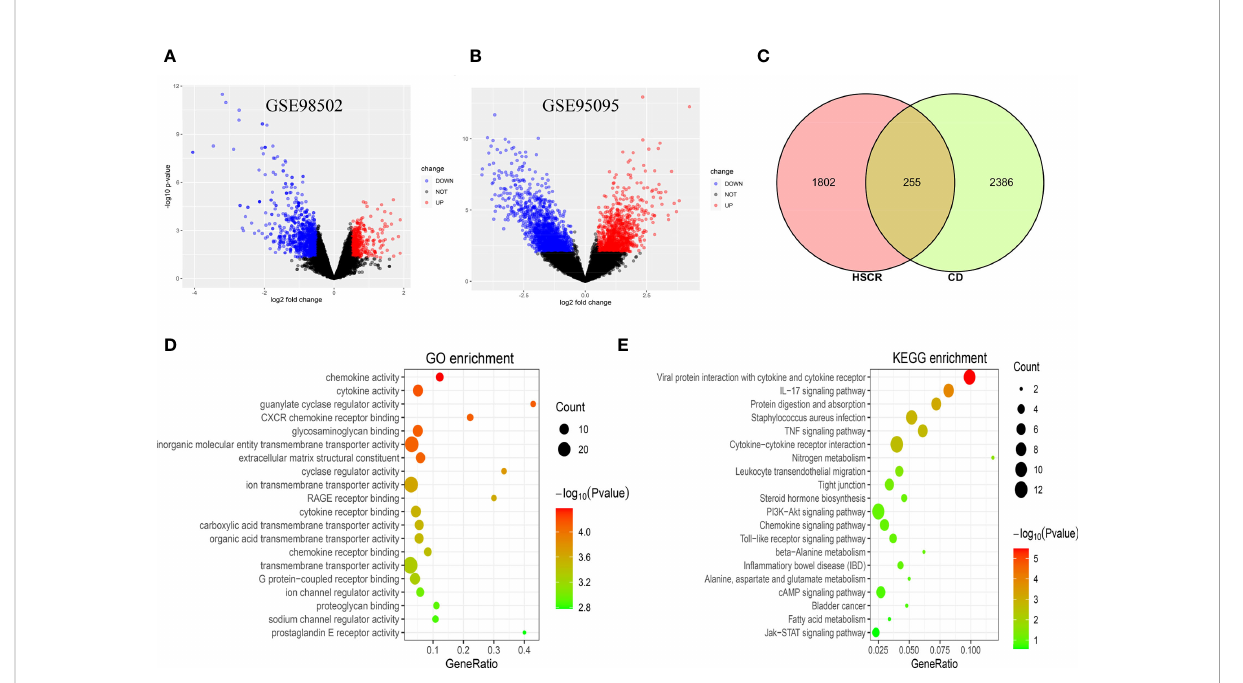
FIGURE 2 (A) The volcano map of GSE98502. (B) The volcano map of GSE95095. Upregulated genes are marked in red; downregulated genes are marked in blue. (C) The two datasets showed an overlap of 255 DEGs. (D, E) The enrichment analysis results of GO and KEGG pathway. DEGs, differentially expressed genes; GO, Gene Ontology; KEGG, Kyoto Encyclopedia of Genes and